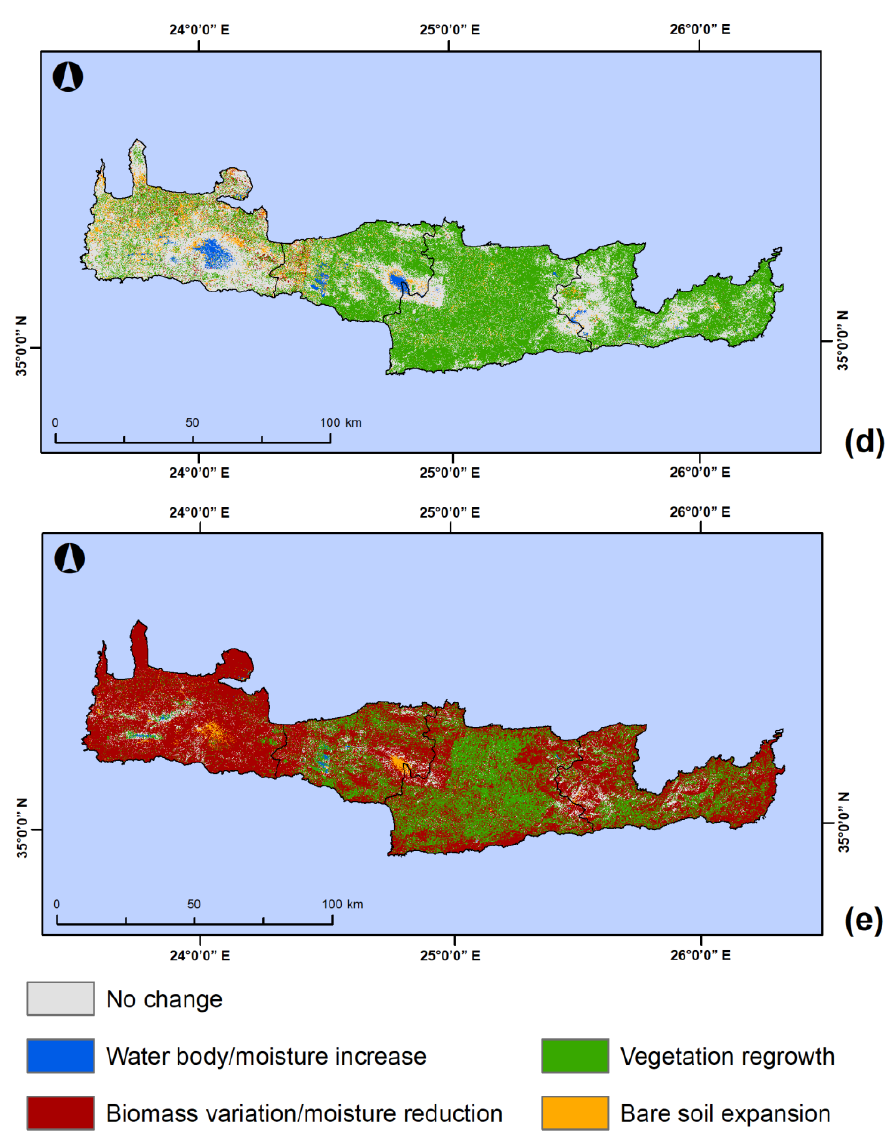
Figure 7. Change direction maps for the period of 2009–2019 from different index combinations: ( a ) NDVI–albedo; ( b ) NDVI–BSI; ( c ) SAVI–albedo; ( d ) SAVI–BSI; ( e )